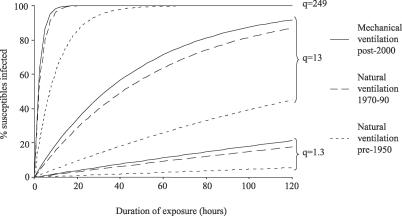
Estimated TB Transmission Risk over Time for Three Sources of Increasing Infectiousness in Naturally versus Mechanically Ventilated FacilitiesThe estimated risk of TB infection over time for exposure to three TB source cases of different infectiousness is shown for pre-1950 naturally ventilated facilities (dotted lines) versus modern 1970–1990 naturally ventilated facilities (dashed lines) versus mechanically ventilated negative-pressure isolation facilities at 12 ACH (continuous lines). The three infectious sources are: q = 1.3 standard ward TB patients who infected guinea pigs studied by Riley [32] (lowest three lines); q = 13 an untreated TB case who infected 27 coworkers in an office over 4 wk [17] (middle three lines); and q = 249 for an outbreak associated with bronchoscopy of a TB patient [14] (uppermost three lines). Median values for all measures of absolute ventilation for each category of naturally ventilated room with all windows and doors open have been used in the model.